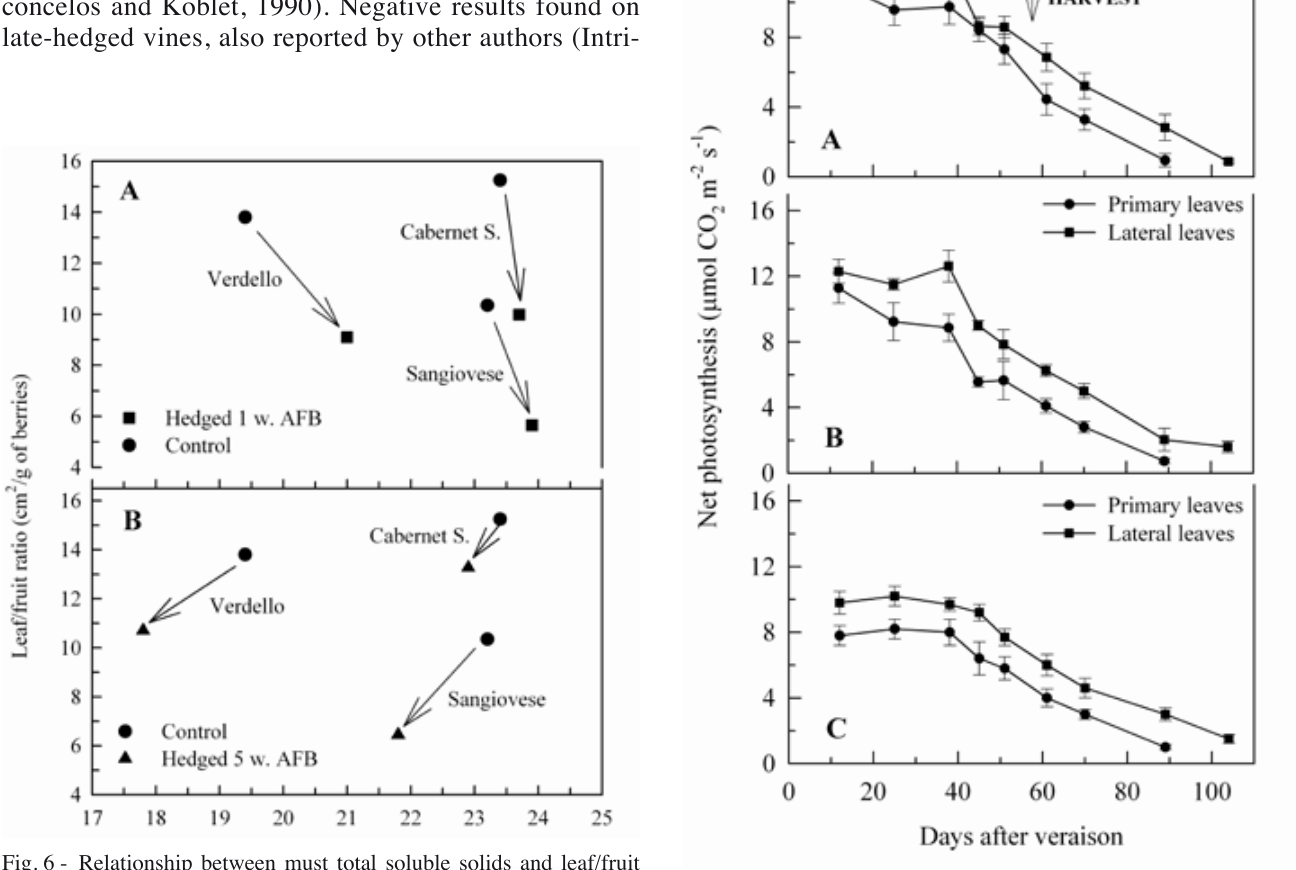
Fig. 7 - Evolution of net photosynthesis of primary and lateral leaves from veraison to leaf fall in Sangiovese, Cabernet Sauvignon and Verdello grapevine cultivars (n = 8 ± se